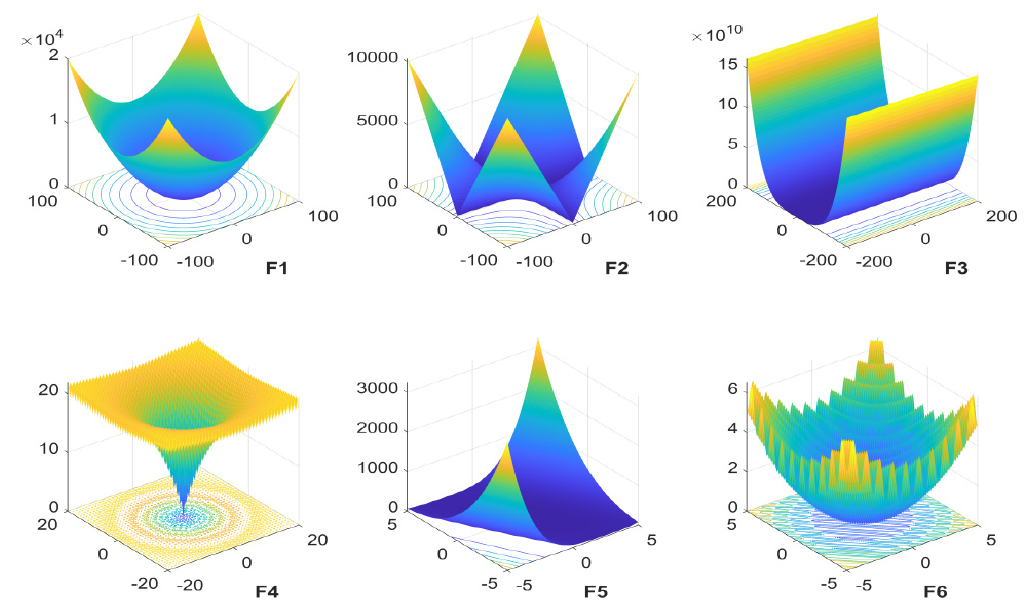
Figure 1. Two-dimensional variable local graph of test function.